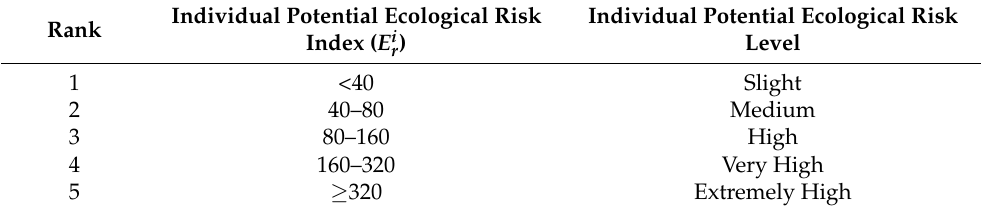
Table 4. Criteria for individual potential ecological risk coefficient indices ( E i r